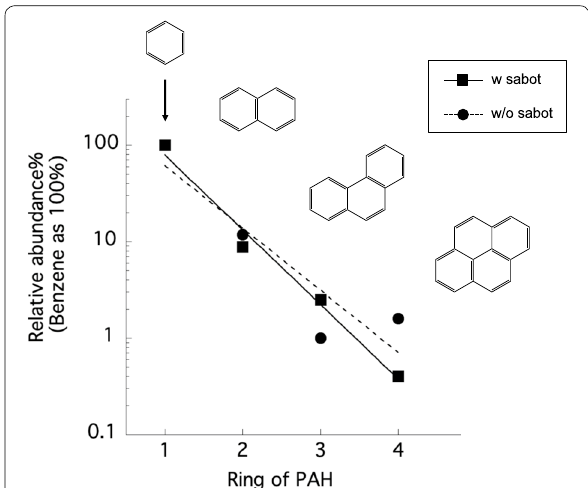
Fig. 7 The relationship between the number of rings of the PAHs and their relative abundance normalized to benzene at 100. The abundance profiles were from benzene (monocyclic), naphthalene (bicyclic), phenanthrene (tricyclic), and pyrene (tetracyclic), where the concentrations of alkyl-PAHs were not included in the determination of each relative abundance. For further description of carbonaceous products, the detailed analysis of soluble organic matter using polar and apolar solvents will have to be performed by high-resolution mass spectrometry with appropriate wet-chemical treatments (e.g., Orbitrap mass spectrometry by Oba et al. 2019; Isotope ratio mass spectrometry by Takano et al. 2015)